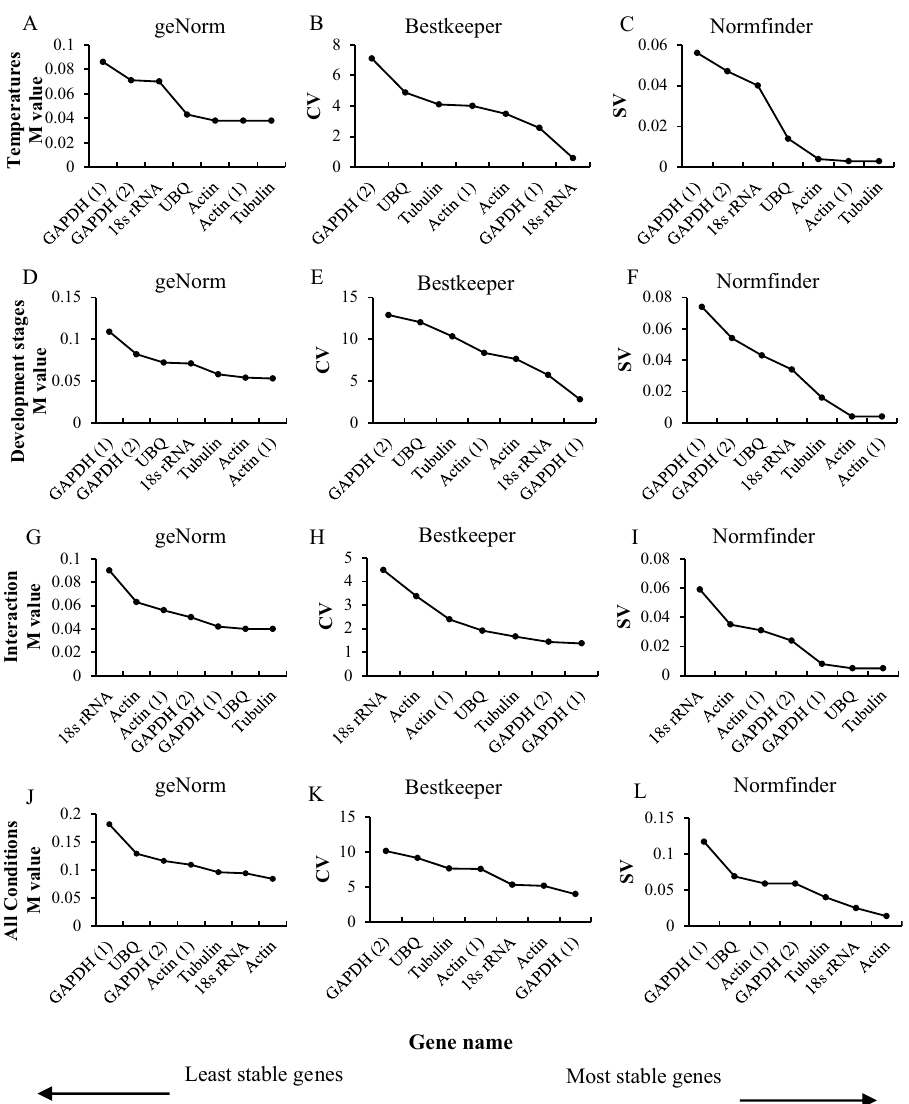
Figure 2. Rankings of reference gene expression stabilities determined by RT-qPCR followed by geNorm, Bestkeeper, and Normfinder algorithm. ( A – C ) correspond to different temperatures; ( D – F ) N. dimidiatum at different developmental stages ; ( G – I ) correspond to pitaya –N. dimidiatum interaction; ( J – L ) correspond to all conditions (at different developmental stages, at different temperatures, and during the pitaya– N. dimidiatum